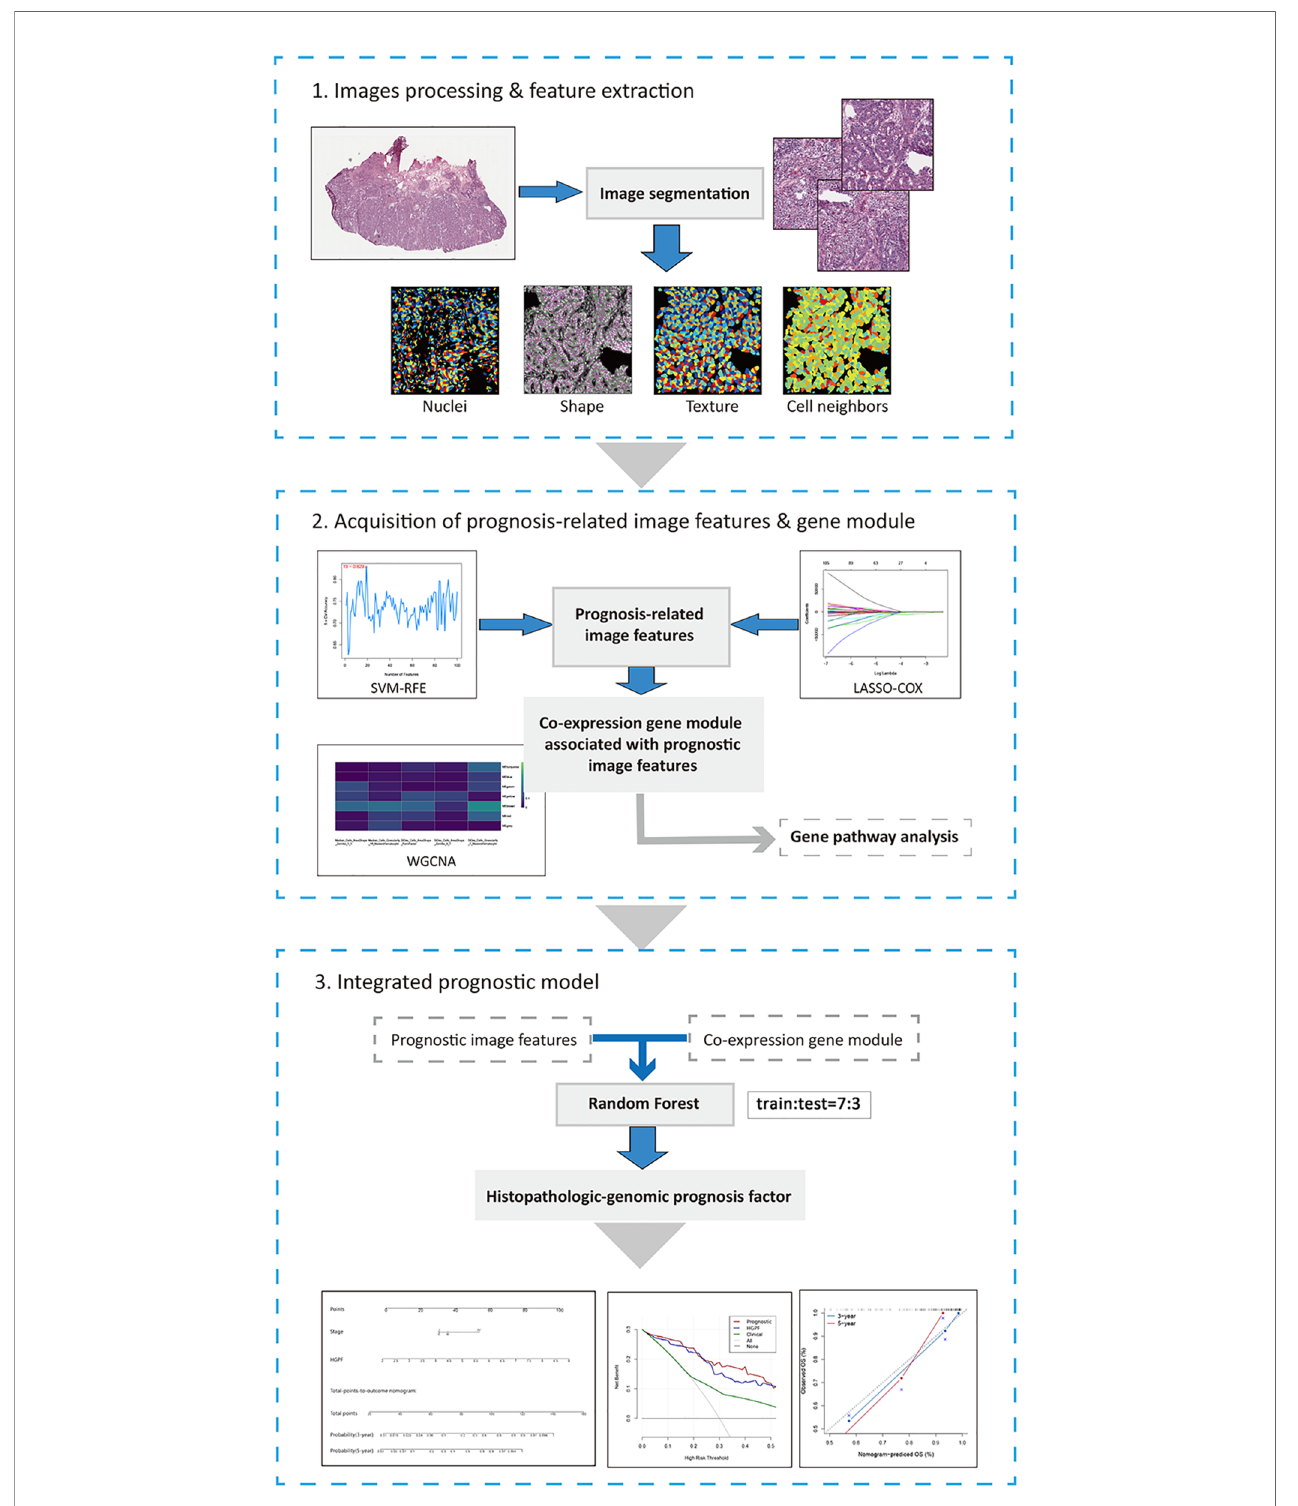
FIGURE 1 | The work fl ow chart of key steps in this study. The whole-slide histopathological images of colon cancer were evenly cropped into sub-images of 1000×1000 pixels. After processing and selecting these sub-images, several image features were extracted by CellPro fi ler for further analysis. Then, LASSO-COX regression and SVM-RFE were performed to acquire prognosis-related image features. And WGCNA was used to identify co-expression gene modules associated with prognostic features. Histopathological features and genomic data were integrated into histopathological-genomic prognosis factor (HGPF) by random forest method with 10-fold cross-validation (the sample ratio of training set and test set is 7:3). Performance of the prediction model was evaluated.